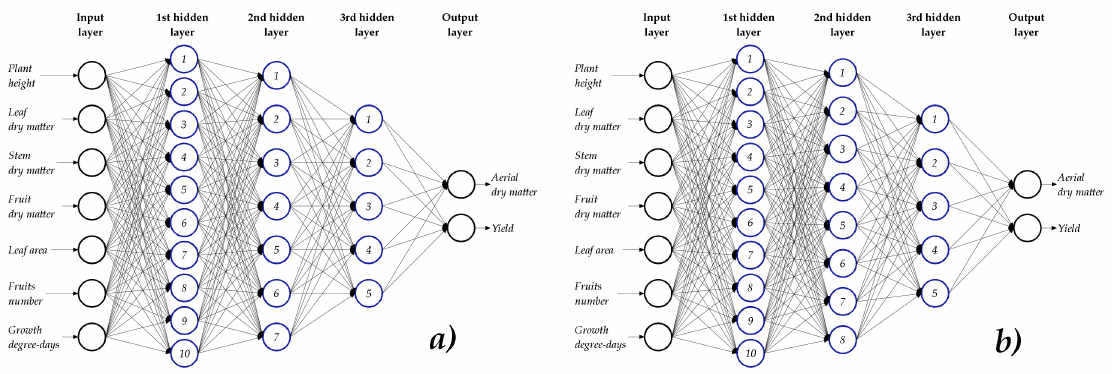
Figure 1. ANN schemes with ( a ) a 7-10-7-5-2 topology for the substrate, and ( b ) a 7-10-8-5-2 topology for the soil.